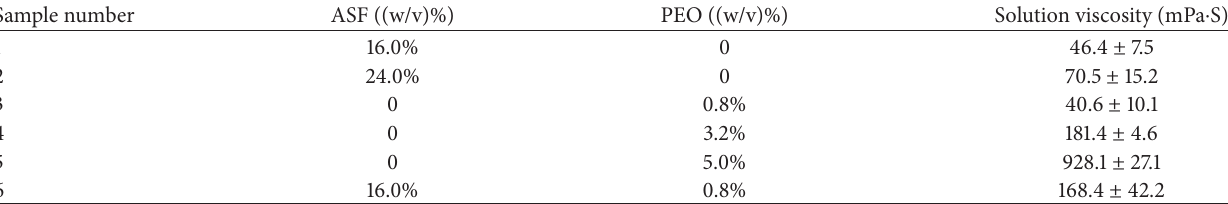
Table 1: Blend ratios, concentrations, and viscosity of electrospinning